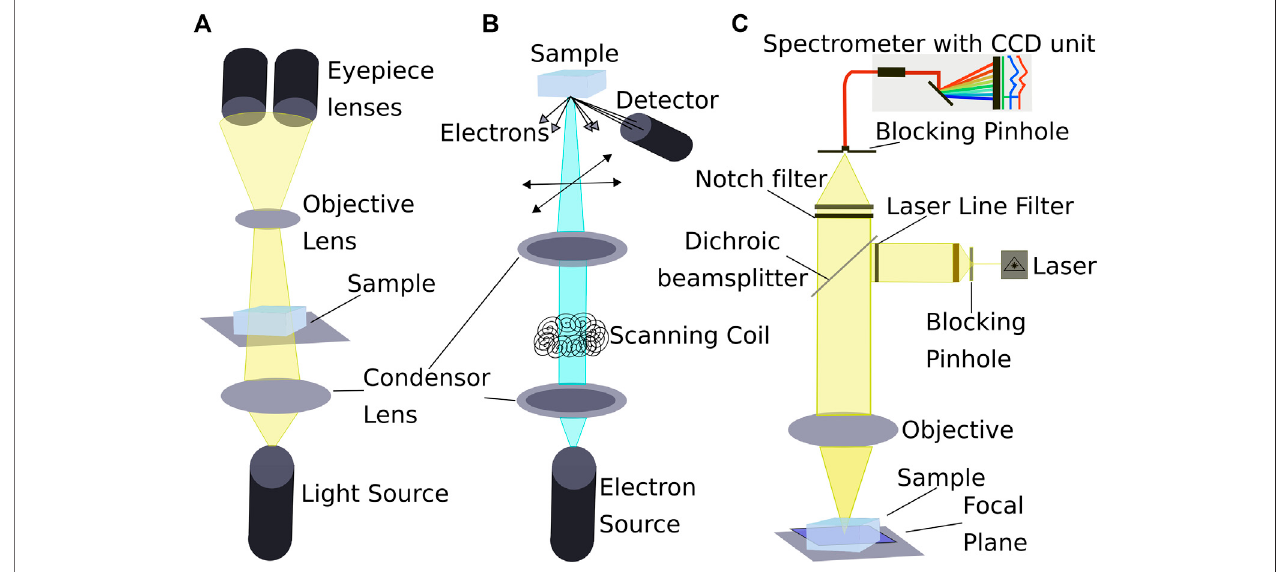
FIGURE3| Popularmethodstolocateimpuritiesinthemicrostructureofice.Schematicrepresentationsofthedifferentsetupsof (A) Opticalmicroscope, (B) SEM,and (C) Confocal Ramanmicroscope. Necessary cooling systems for cryo-useare not shown. CompiledfromReimer(1998); Dieing etal. (2011); and Markaki and Harz(2017).